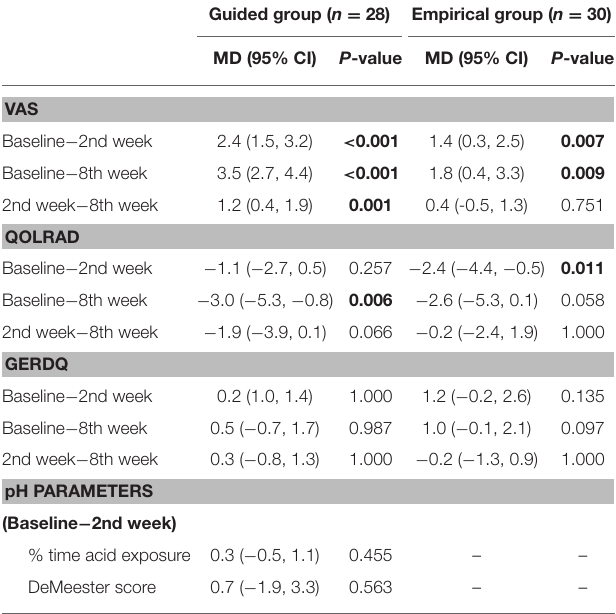
TABLE 1 | Results of within-group differences between variable scores of the guided and empirical groups. Guided group ( n = 28) Empirical group ( n =